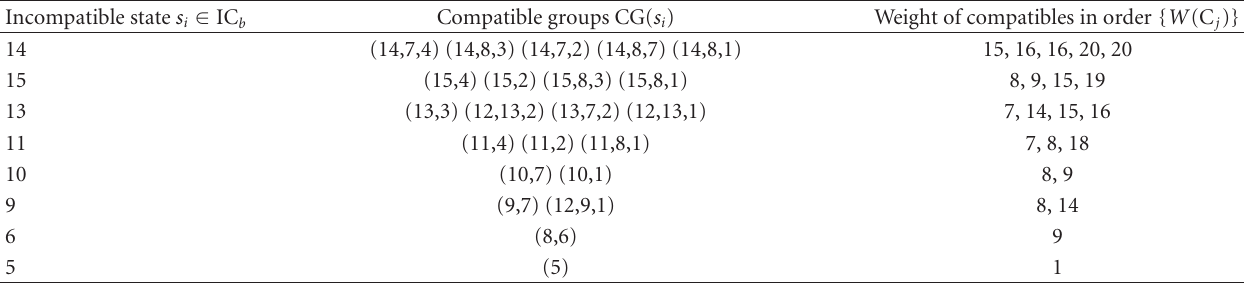
Table 2: Compatible groups of M 1